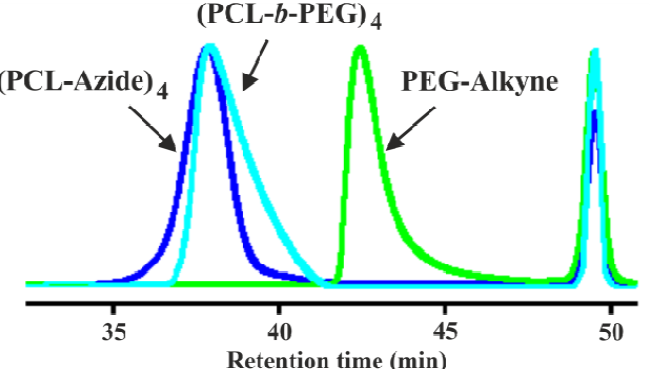
Figure 4. Gel permeation chromatography (GPC) overlay of linear poly(ethylene glycol) (PEG)-alkyne, (PCL-azide) and the resulting (PCL- b -PEG) 4 (THF) at 30 °C.